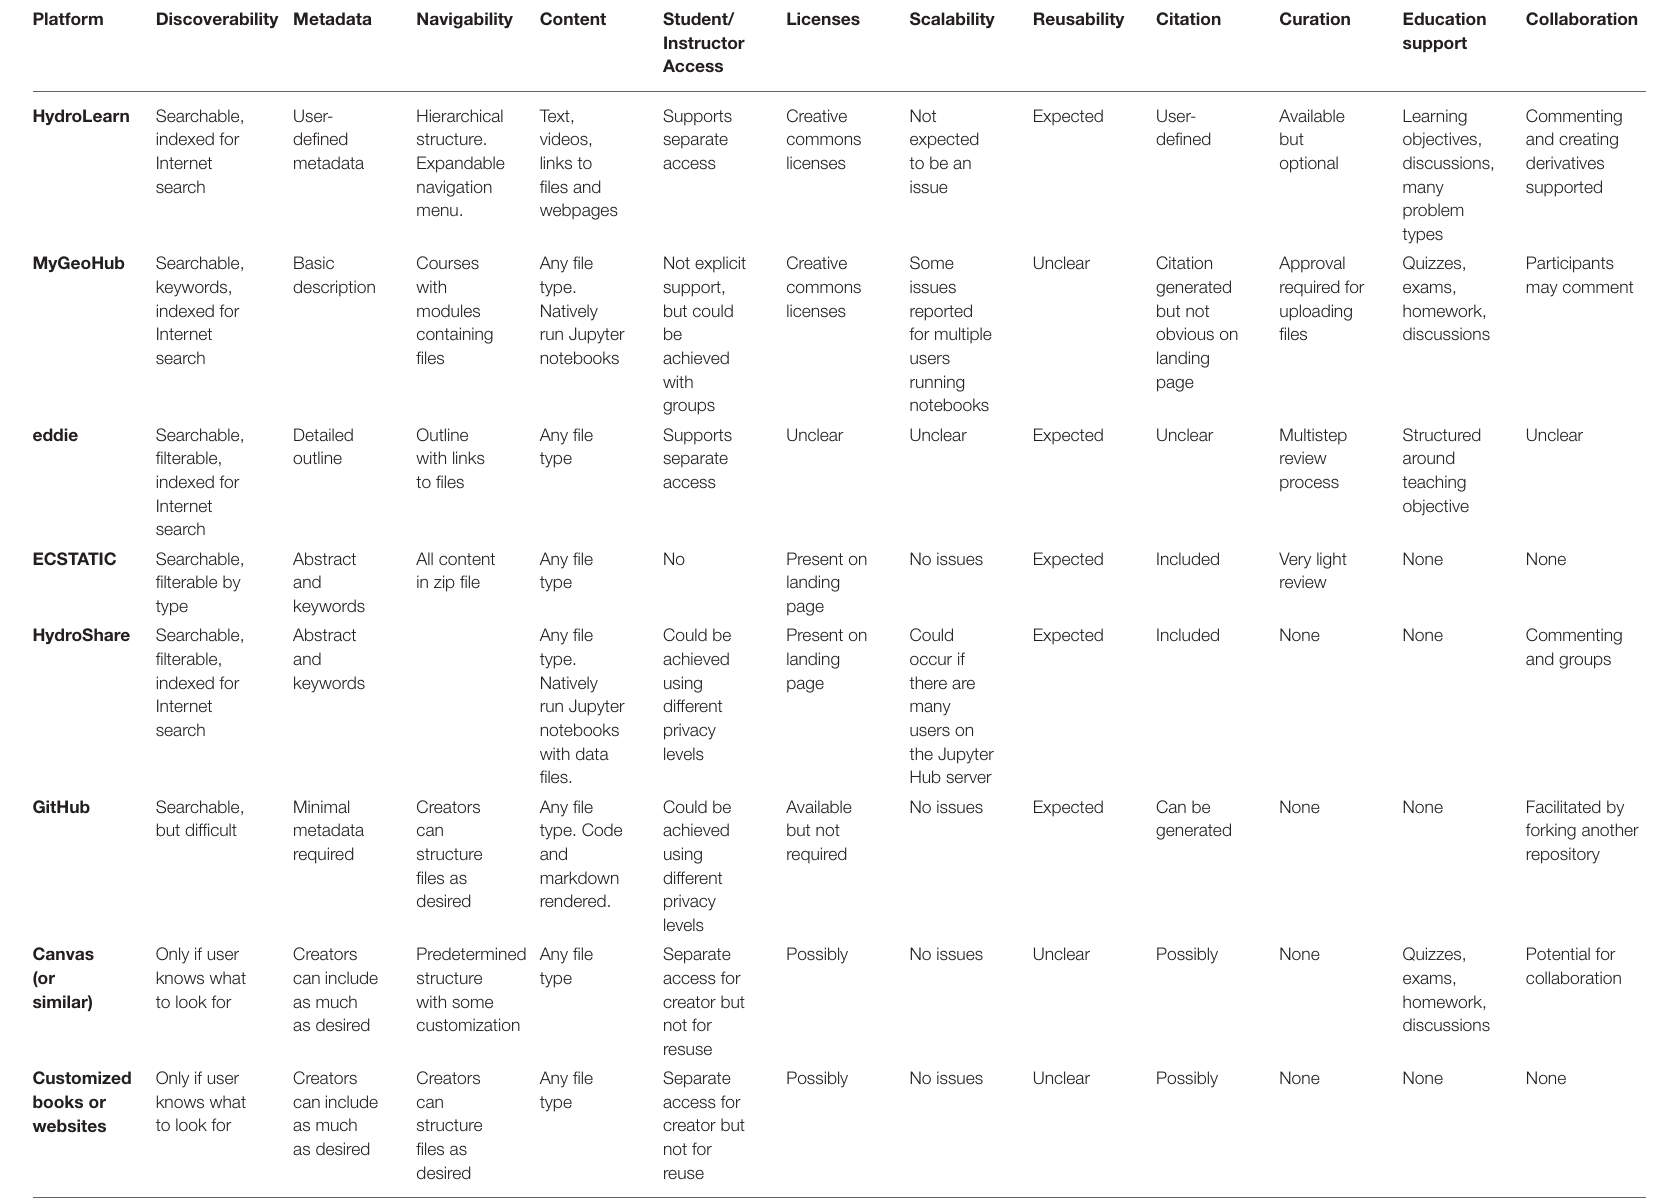
TABLE 4 | Characteristics of educational platforms related to instructor-defined criteria.